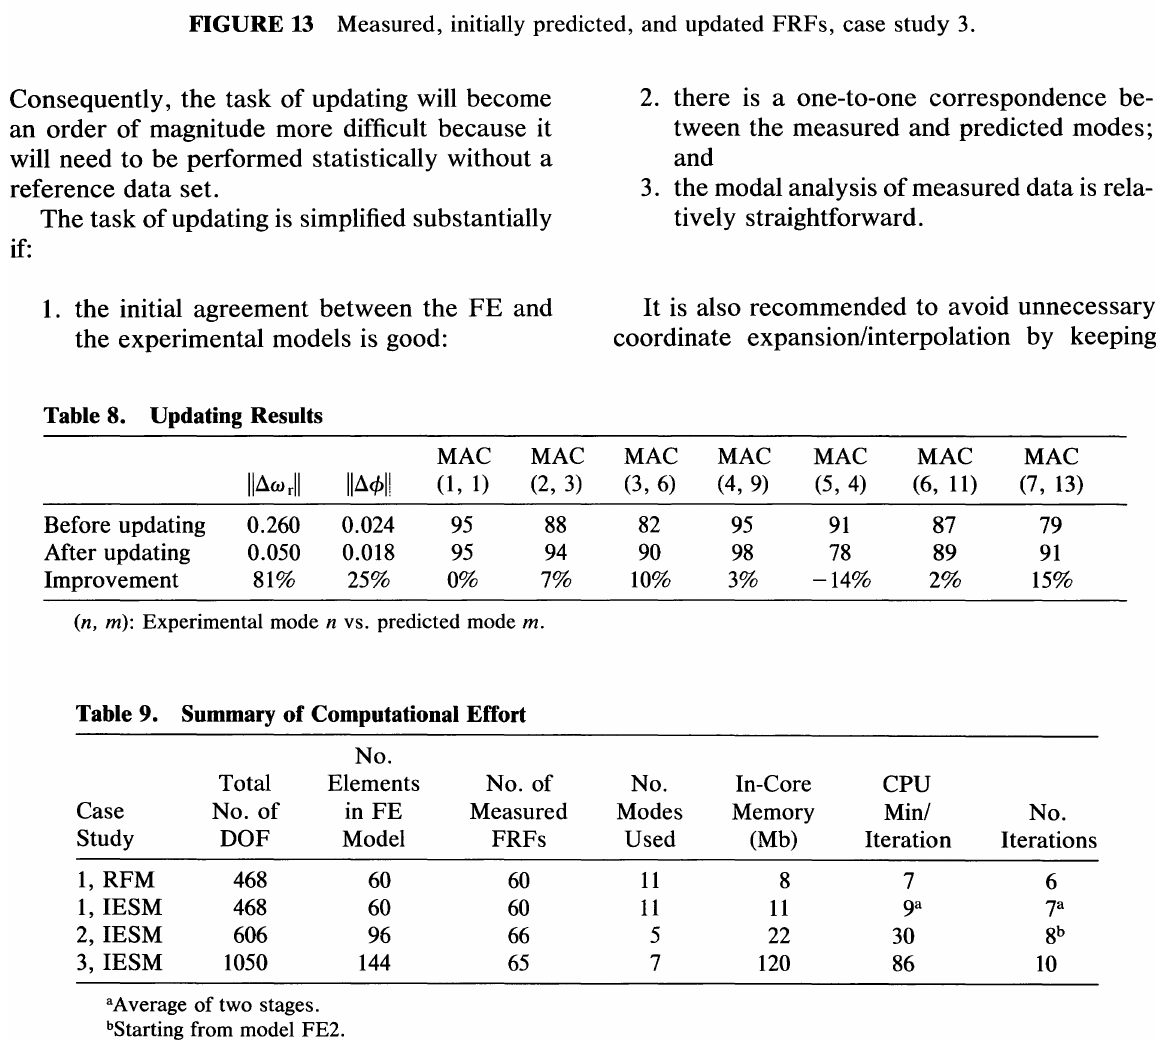
Table 9. Summary of Computational